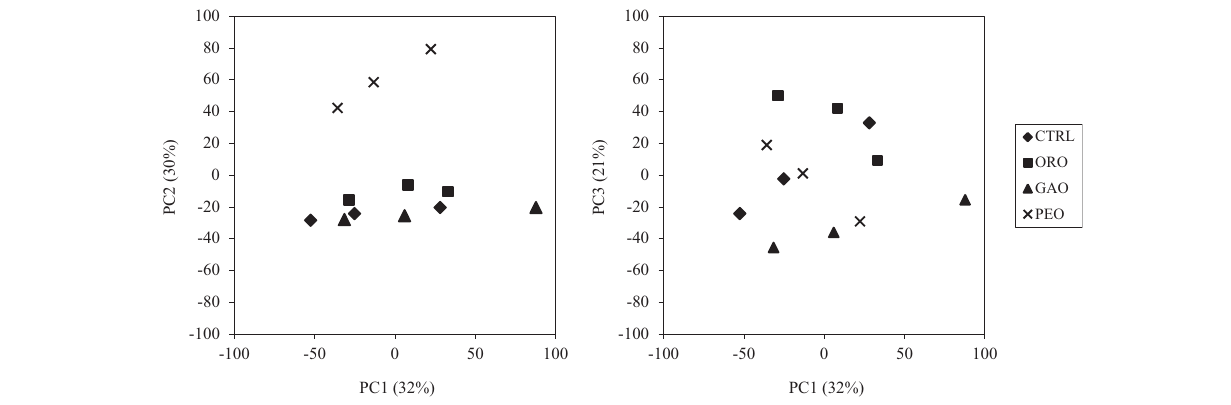
FIGURE 2 | PCA plots of the bacterial OTUs detected by the RumenBactArray among the in vitro ruminal cultures. CTRL, control; ORO, origanum oil; GAO, garlic oil; PEO, peppermint oil. All the treatments were in